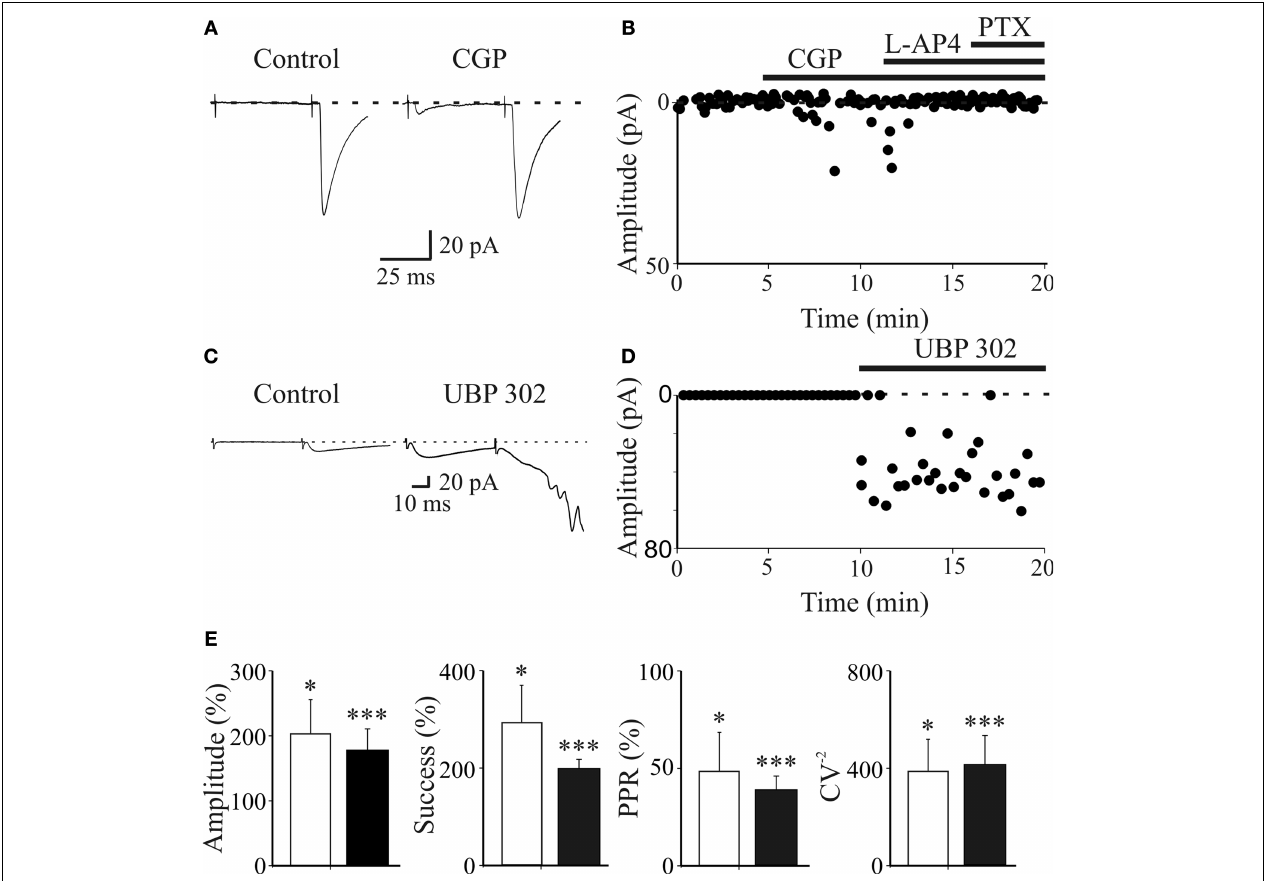
FIGURE 4 | Presynaptic GABA and kainate receptors localized on MF UBP 302 (10 µM). Note that UBP 302 induced the appearance of the fi rst B terminals down regulate GABA release contributing to synapse silencing. response and enhanced the amplitude of the second one giving rise to an evoked (A) A “presynaptically” silent neuron before (left) and during bath application of GDP. (E) Each column in the graph represents the summary plot of peak CGP55845 (1 µM, right). Each trace is the average of 20 responses. Note the amplitude, successes rate, PPR and inverse squared of CV of MF-GPSCs appearance of a synaptic current in the presence of CGP55845 (each trace is the (expressed as percentage of controls) during CGP55845 (white columns; n = 10) average of 20 individual samples). (B) The peak amplitude of MF-GPSCs shown in or UBP 302 (black columns; n = 19). While amplitude and successes refer to both A, before and during bath application of CGP55845, L-AP4 and PTX (closed bars) silent and non-silent neurons, PPR and CV − 2 only to non-silent cells. * p < 0.05; is plotted against time. (C,D) as in (A,B) but before and during bath application of ** p < 0.01; *** p < 0.001. (A,B) modifi ed from Safi ulina and Cherubini,